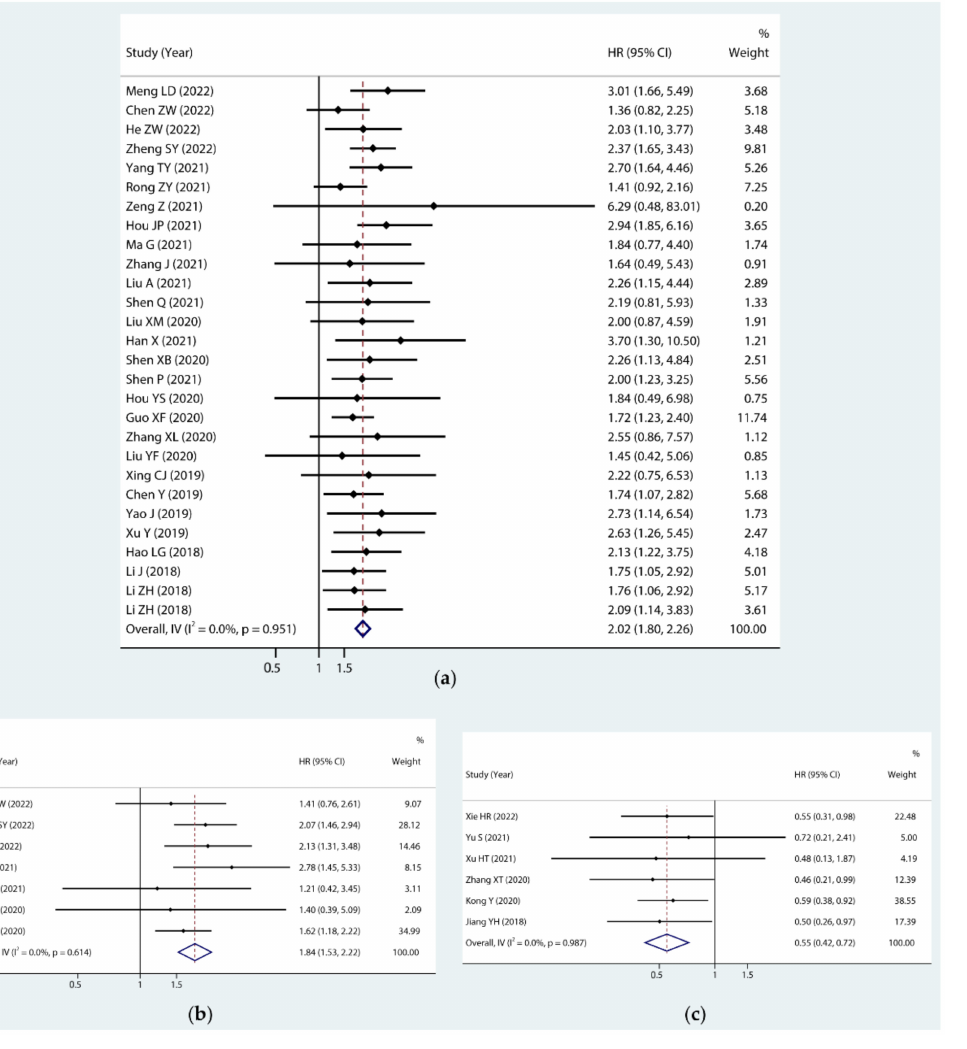
Figure 2. Forest plots of the OS ( a ), DFS/PFS ( b ) for upregulated circRNAs, and OS ( c ) for downregu- lated